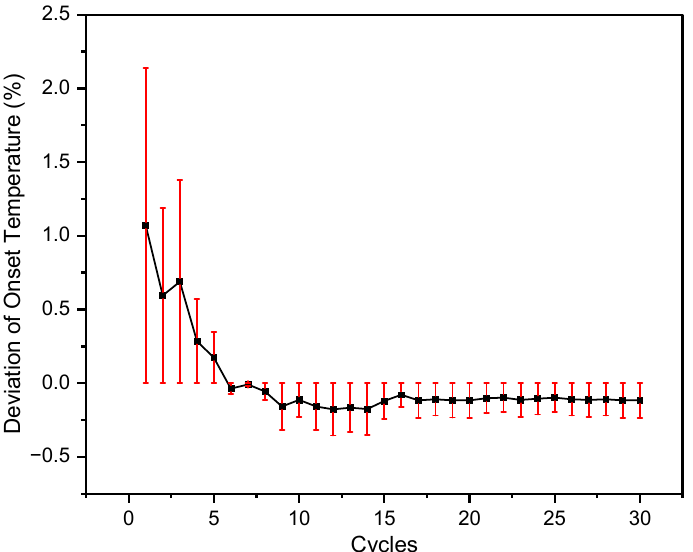
Figure 3. Deviation of melting temperature with error bars illustrated for each cycle from the average calculated value for the best-chosen sample i.e., 32 mol% LiCl-68 mol% LiOH.